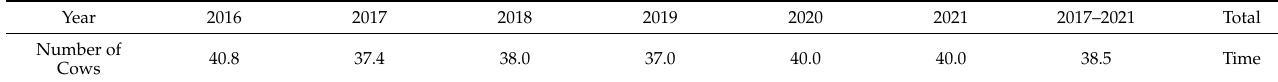
Table 2. Yearly feed supplementation throughout the study, calculated as intake per cow of 503 kg